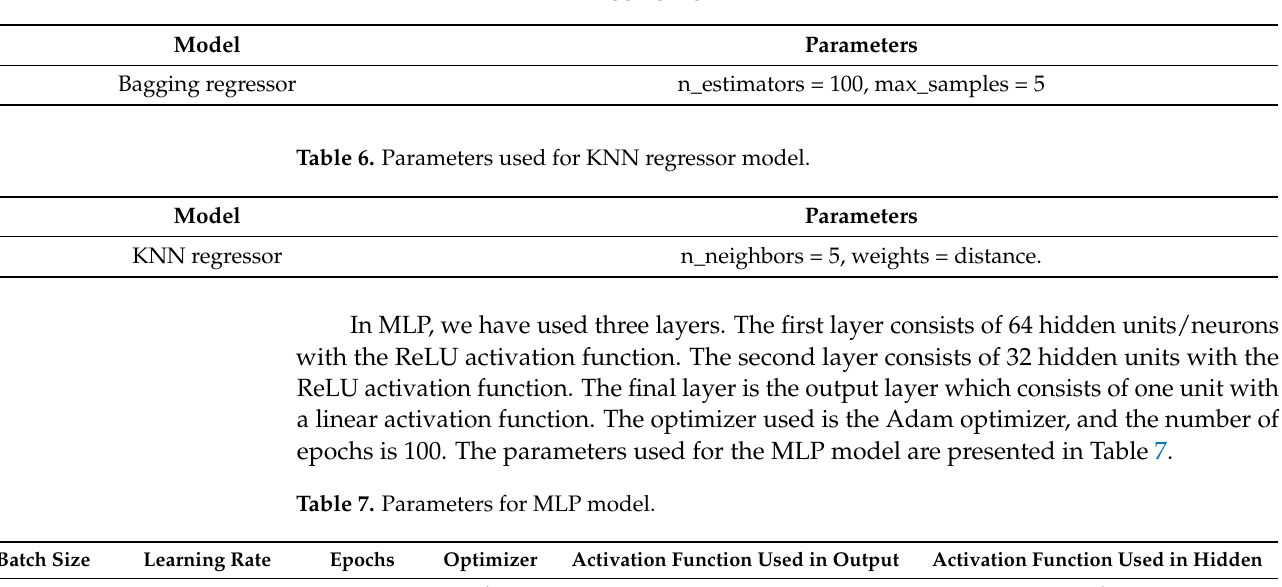
Table 5. Parameters used for bagging regressor model.